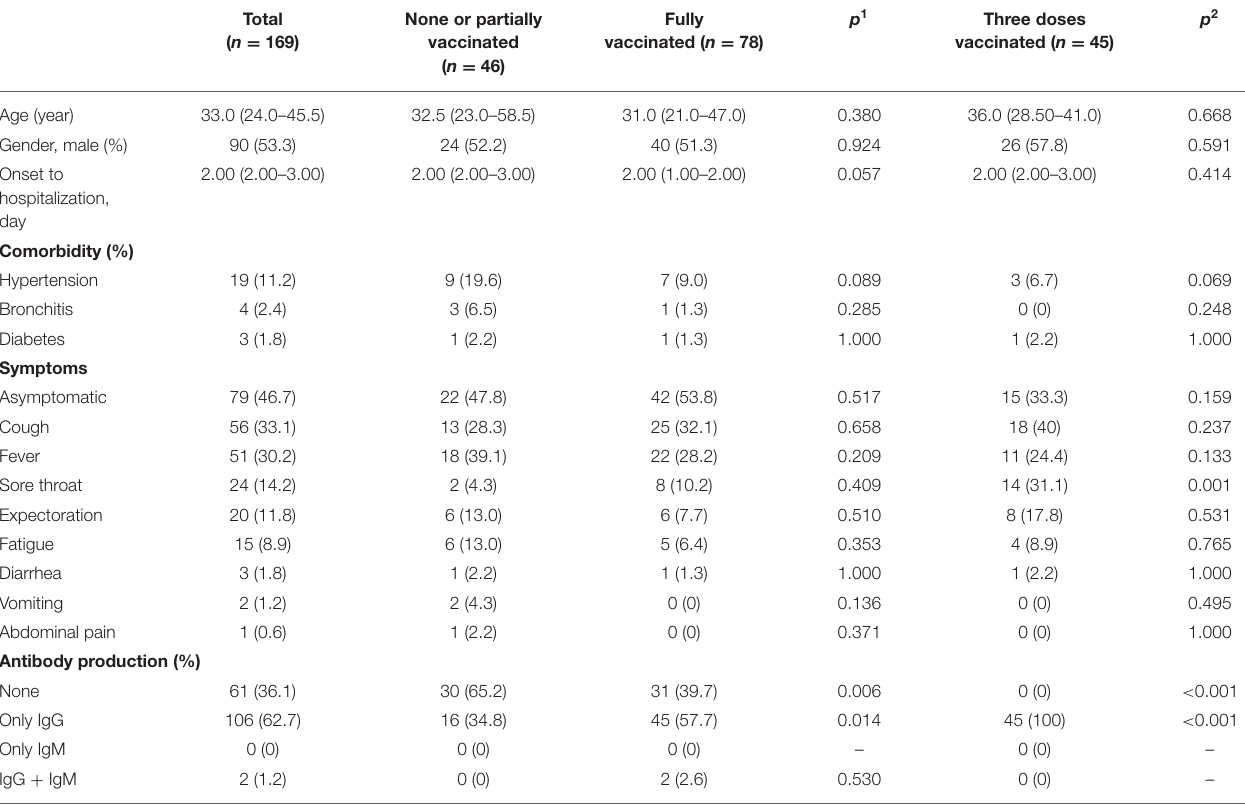
TABLE 1 | Demographic information, medical/immunization history, clinical symptom, and antibody production in the COVID-19 patients infected by the omicron variant in Suzhou, China, in February and March